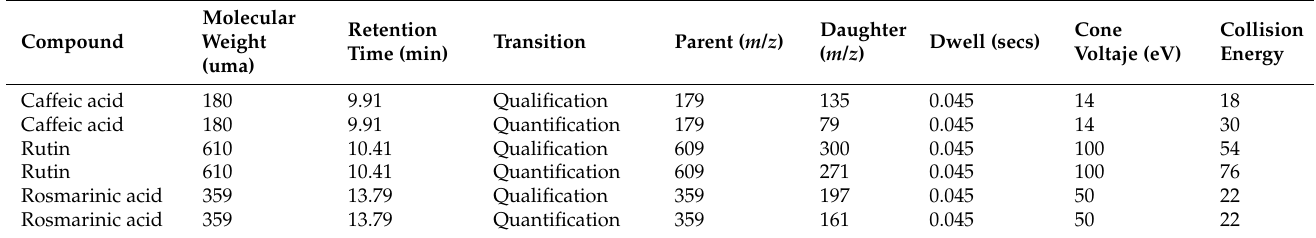
Table 4. MRM analysis conditions for quantification and qualification of phenolic compounds in extracts obtained from Cordia dodecandra